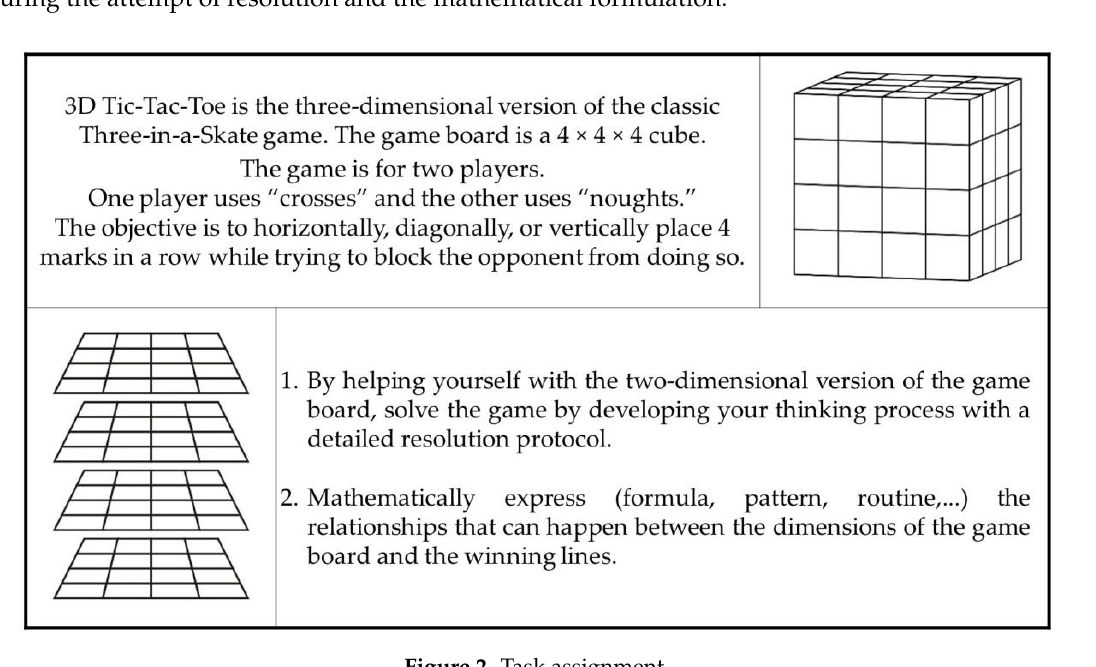
Figure 2. Task assignment. Figure 2. Task